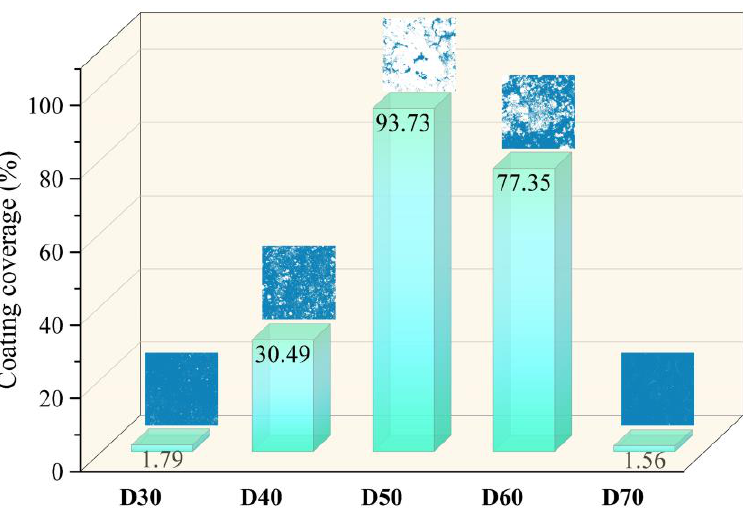
Figure 5. Coating coverages of the deposition products (D30 −